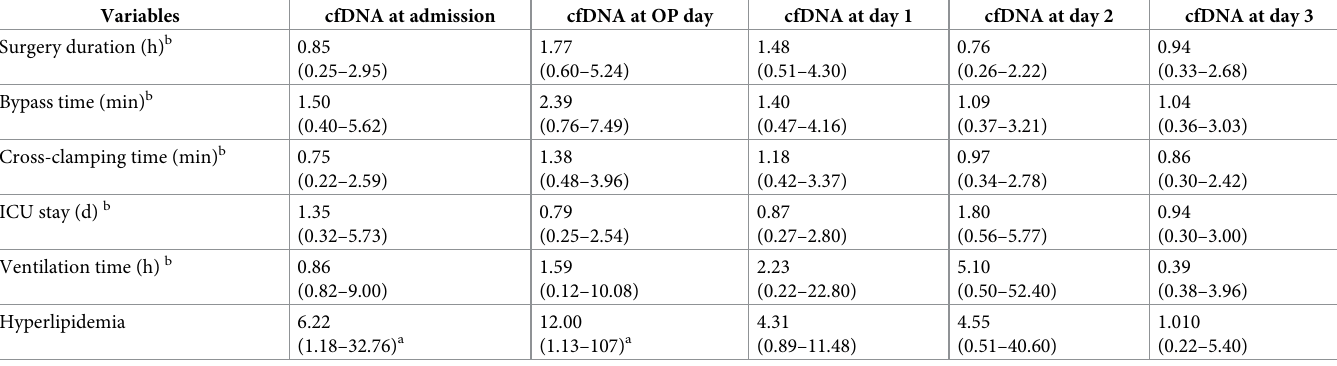
Table 4. Predictors for postoperative occurrence of AKI. Odds ratios refer to cfDNA values greater than threshold for AKI development.